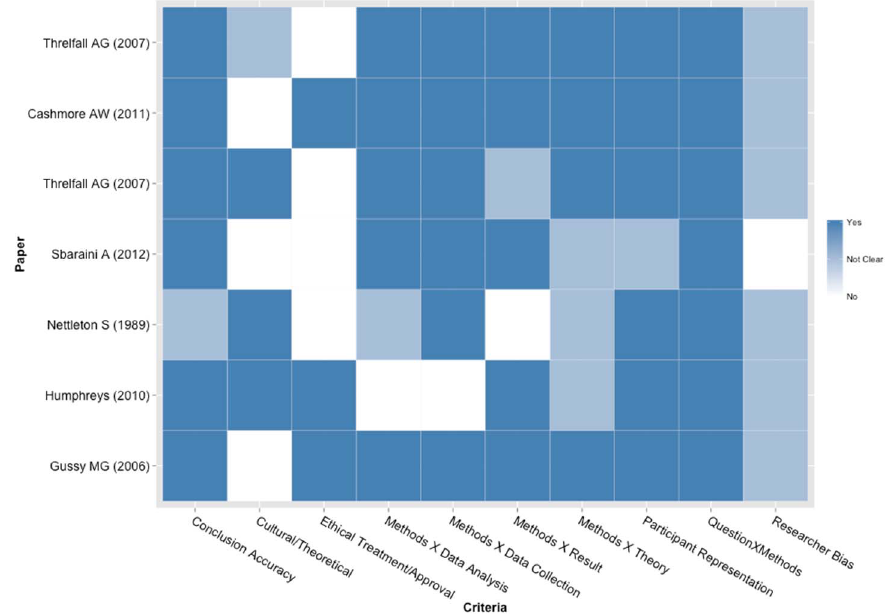
Figure 3. Heat map showing a gradient of quality indicators for each individual qualitative study included in the analysis. Colors vary from white (No), light blue (Not clear) and blue (Yes) representing the three categories used in the quality assessment.